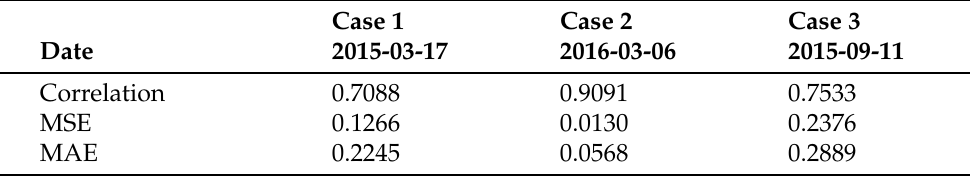
Table 4. Correlation coefficient, MSE and MAE between GNSS ROTI and Swarm RODI for selected cases.